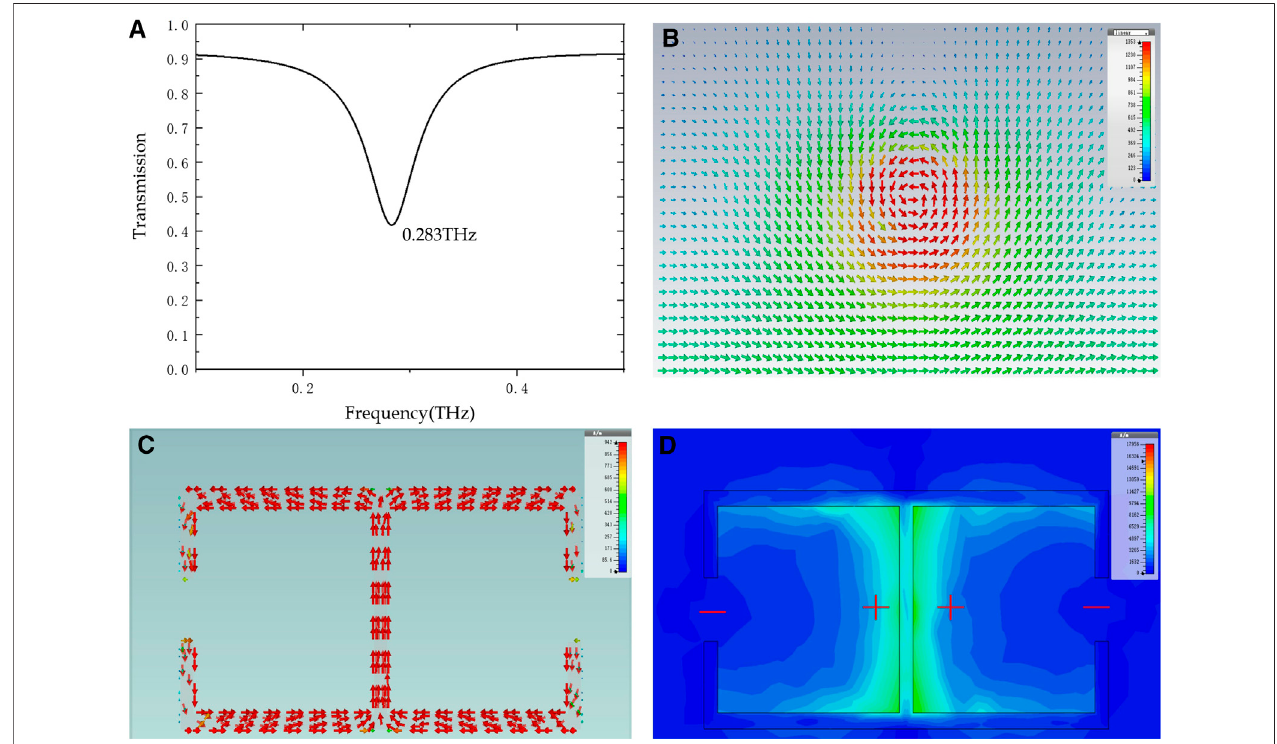
FIGURE2|(A) Simulated transmissionspectrum oftheproposedstructurewithaFermilevelof30 meV. (B) Magneticcurrentdistribution. (C) Surfacecurrent. (D) The magnetic fi eld distribution of the structure. (B – D) are at a resonance frequency of 0.283 THz.